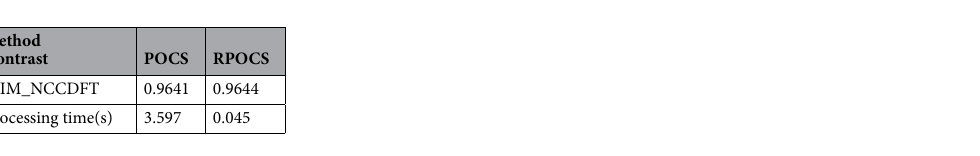
Table 1. SSIM_NCCDFT evaluation contrast and processing time of the two restoration